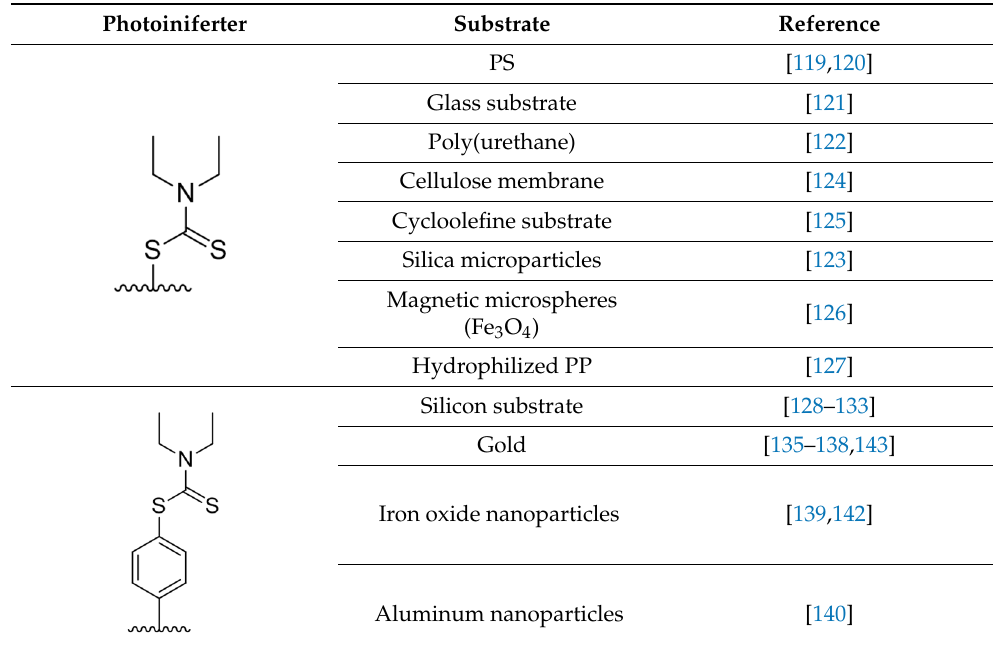
Table 2. Summary of surface coupled photoiniferters.